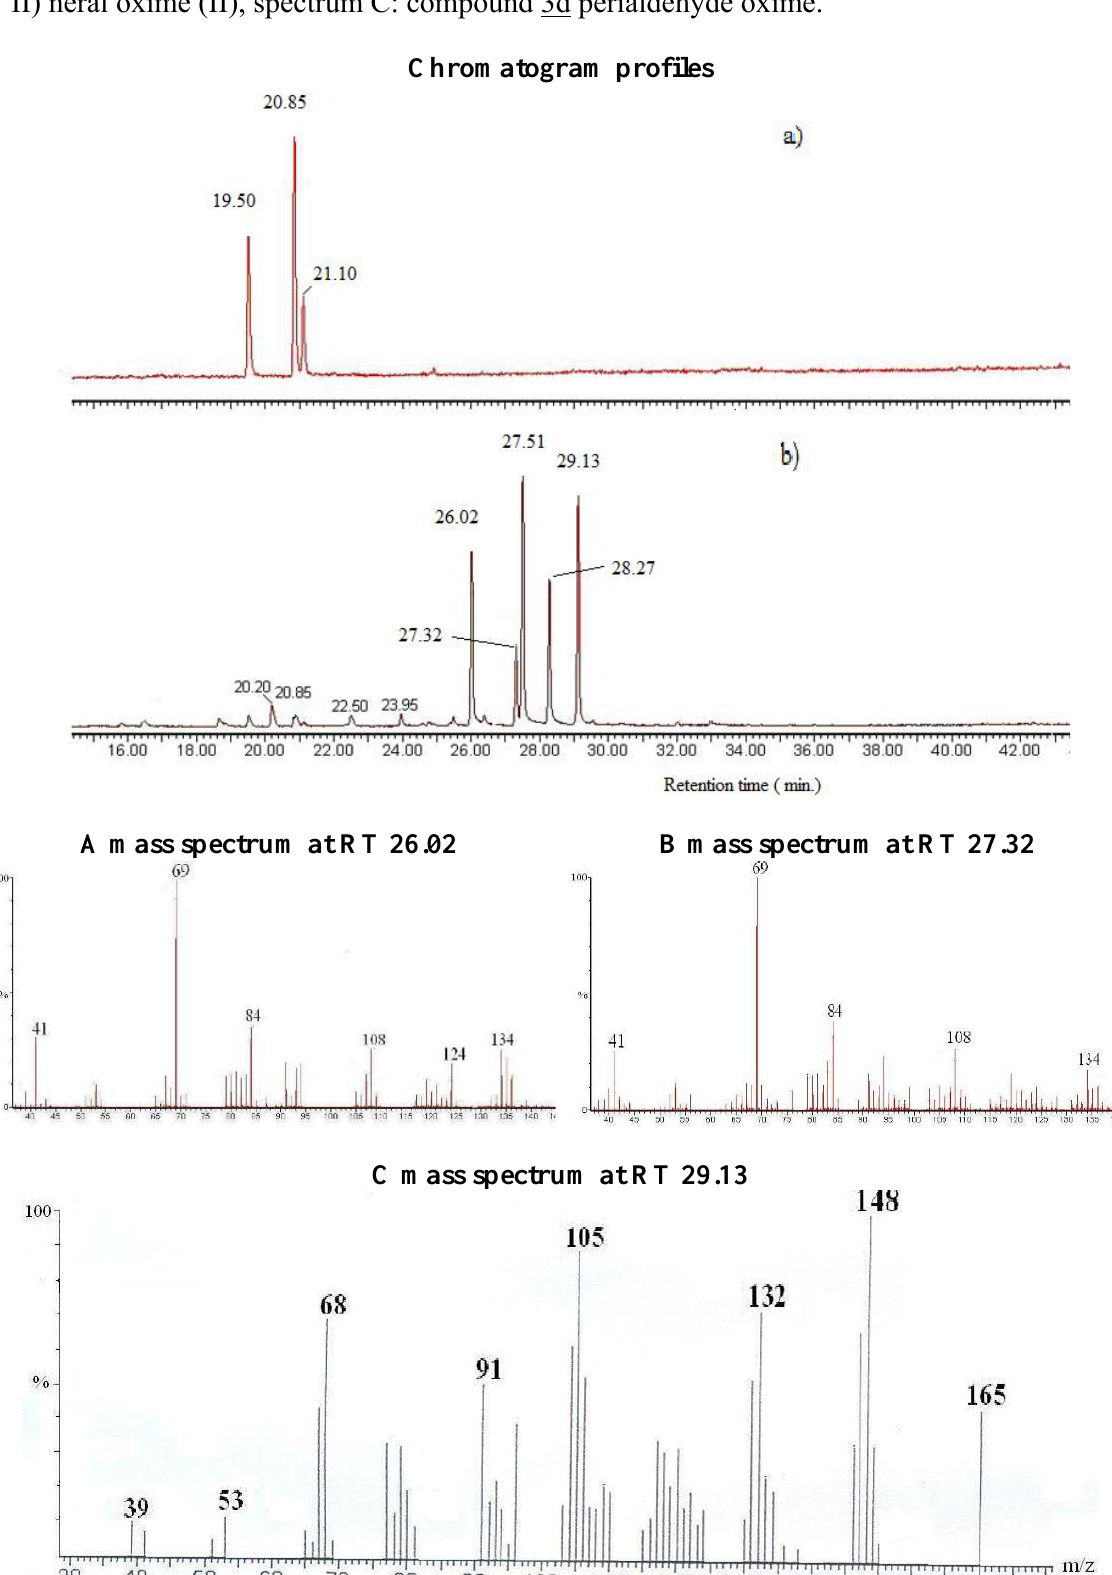
Figure 1. Comparative changes in GC chromatogram profiles of Lippia multiflora a) carbonyl extract (CE), b) oximation product (OP) and mass spectra of the oximes. Spectrum A: compound 2b (Isomer I) neral oxime (I), spectrum B: compound 2b (Isomer II) neral oxime (II), spectrum C: compound 3d perialdehyde